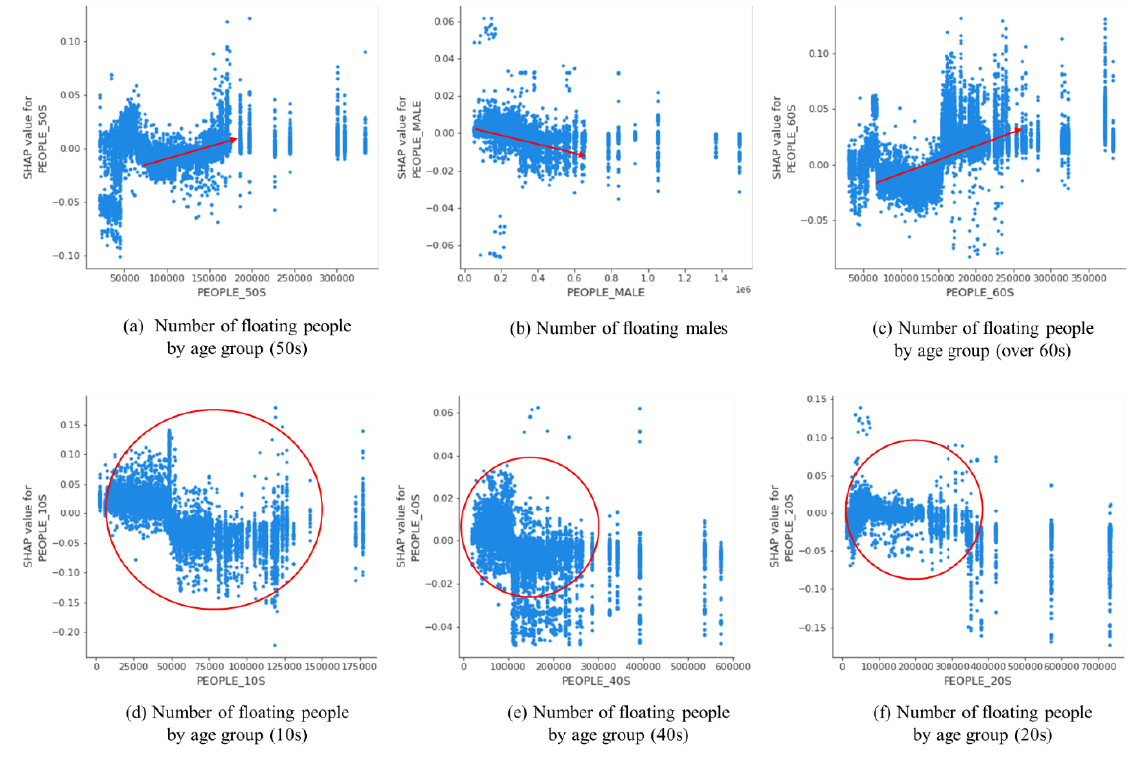
Figure 8. Dependence plots for six features from the floating population category.